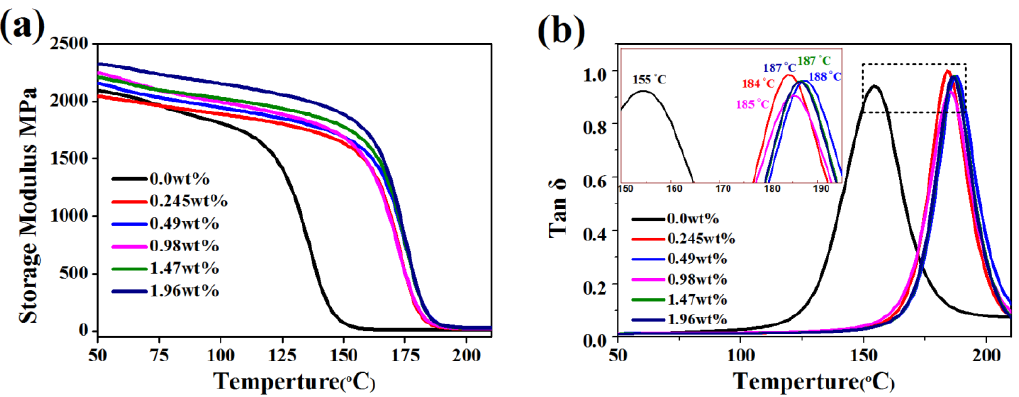
Figure 7. ( a ) The storage modulus; and ( b ) tan d of epoxy/GPLP composites at 1 Hz frequency. Table 1. the thermo-mechanical properties of epoxy/GPLP composites and crosslink density ( V e ).